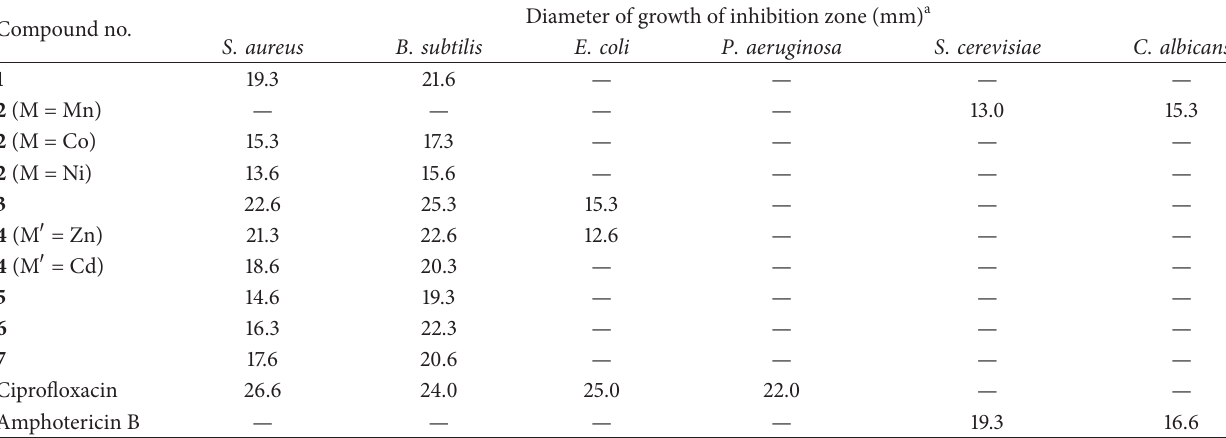
Table 4: In vitro antimicrobial activity of synthetic chemical compounds through agar well diffusion method. Compound no.